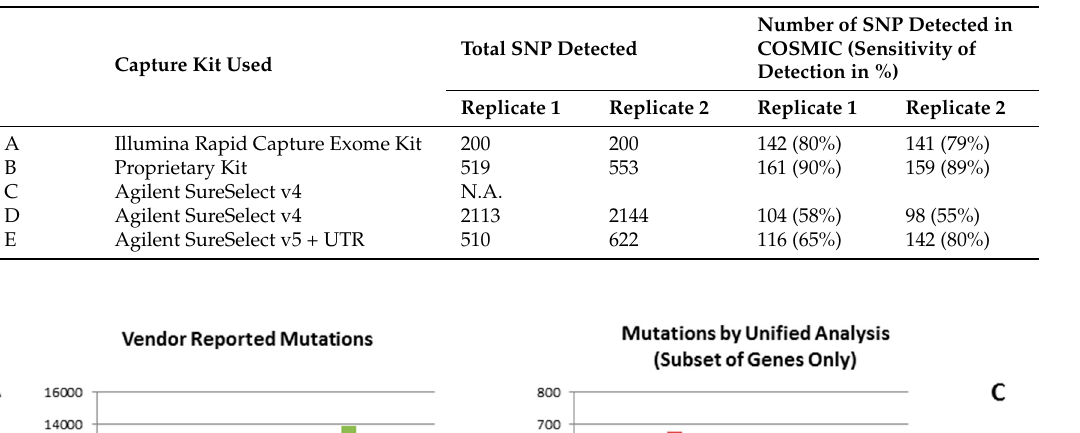
Table 2. WES accuracy estimate using tumor and normal cell line mix (sample S1). Thirty percent DNA from tumor cell line HCC1143 and 70% DNA from normal cell line HCC1143BL derived from same donor. Total 178 COSMIC mutations were expected. Sample S1 data is not available for Lab C (as N.A in the table).